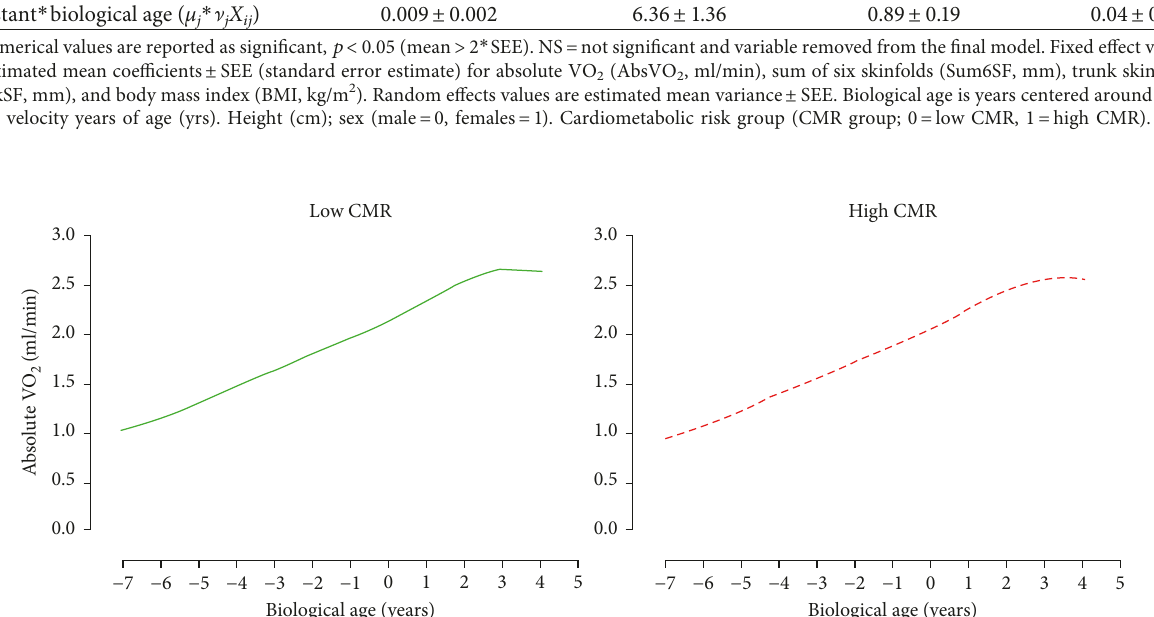
Figure 2: Predicted adolescent absolute VO 2 growth trajectories for individuals categorized as having low and high cardiometabolic risk (CMR) in adulthood. Predicted models adjusted for biological age, height, and